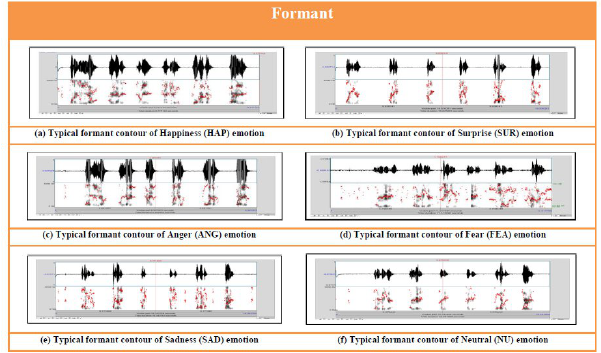
Fig. 14. Asian speakers typical formant contour of basic emotions.